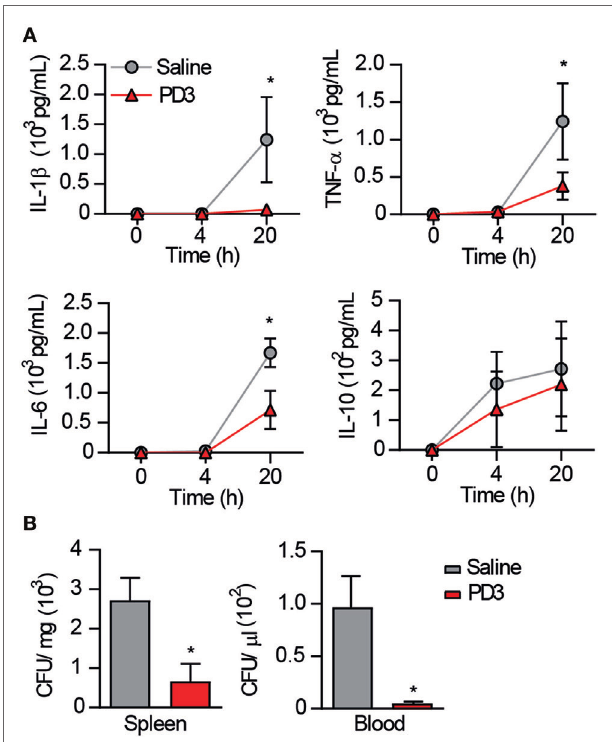
FigUre 7 | Effect of CD6.PD3 therapeutic infusion on cytokine plasma levels and bacterial load following cecal ligation and puncture (CLP)-induced sepsis. (a) C57BL/6J mice were intravenous infused 1 h post CLP with saline ( n = 7) or CD6.PD3 peptide (6 mg/kg; n = 9), and cytokine plasma levels were monitored by ELISA at different time points (4 and 20 h) thereafter. Data are expressed as mean ± SD. (B) Same mouse groups as in (a) were monitored for blood and spleen bacterial load at different time points (4 and/or 20 h) following CLP induction. Data are expressed as mean ± SD of colony-forming units (CFU)/mg (spleen) or CFU/ μ L (blood). In all cases, statistical differences were evaluated using a two-tailed Student t -test (* P <